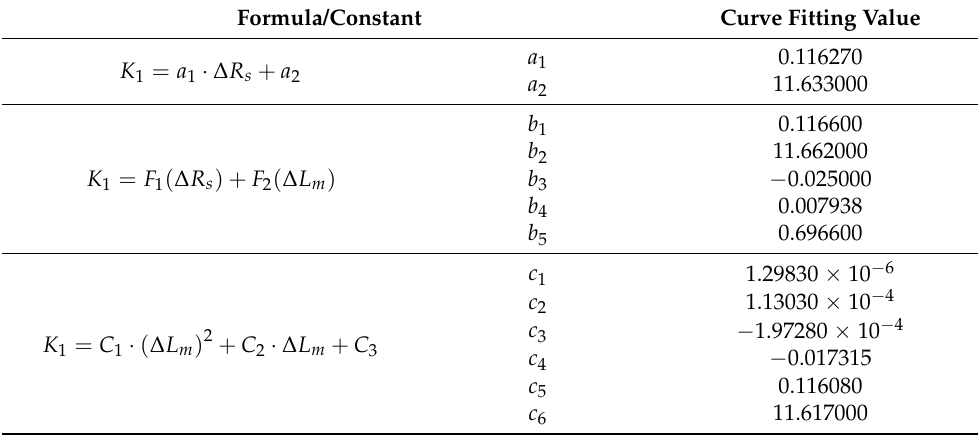
Table 1. Extracted formulas and associated